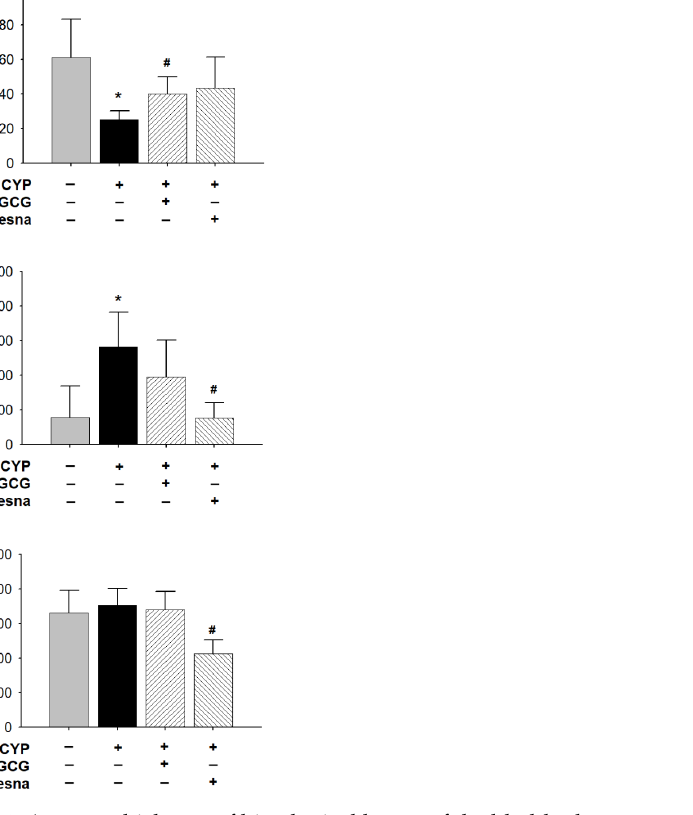
Figure 4. Average thickness of histological layers of the bladder between group 1—saline-injected control, group 2—CYP + placebo with normal saline, group 3—CYP + TGCG (200 mg/kg), and group 4—CYP + Mesna (30 mg/kg). Each bar in the figures denotes the mean ± standard deviation. * p < 0.05 contrasted to control group. # p < 0.05 contrasted to CYP group.